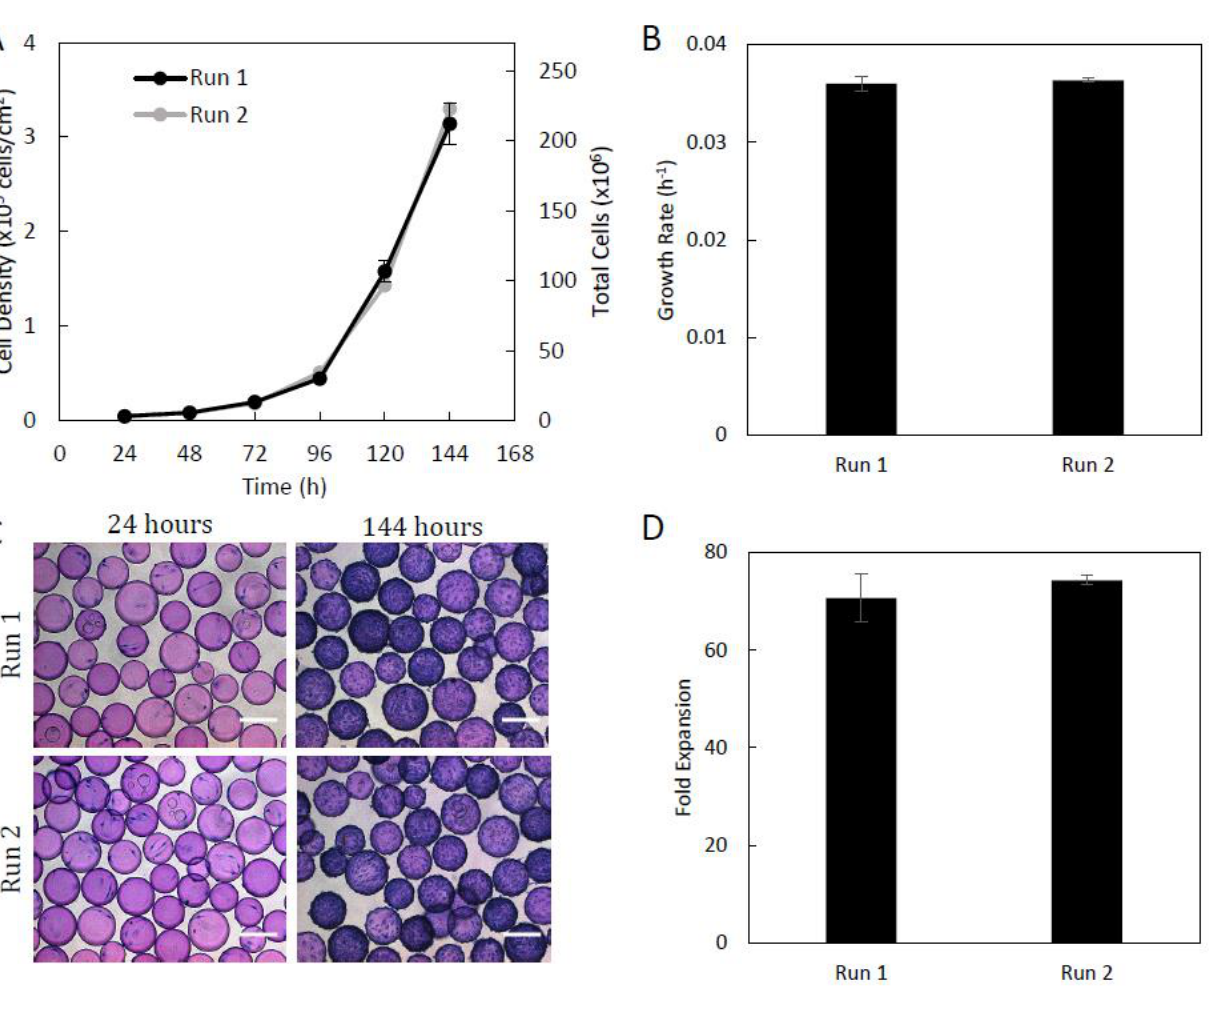
Figure 3. Growth kinetics of Sk-SCs expanded in 500 mL DASGIP bioreactors. Daily samples were taken over the culture duration to generate growth curves ( A ) and to calculate the growth rate ( B ) and fold expansion ( D ). ( C ) Photomicrographs of cell-laden microcarriers after 24 and 144 h of culture. Scale bars represent 200 μm. Error bars represent one standard deviation of the mean.